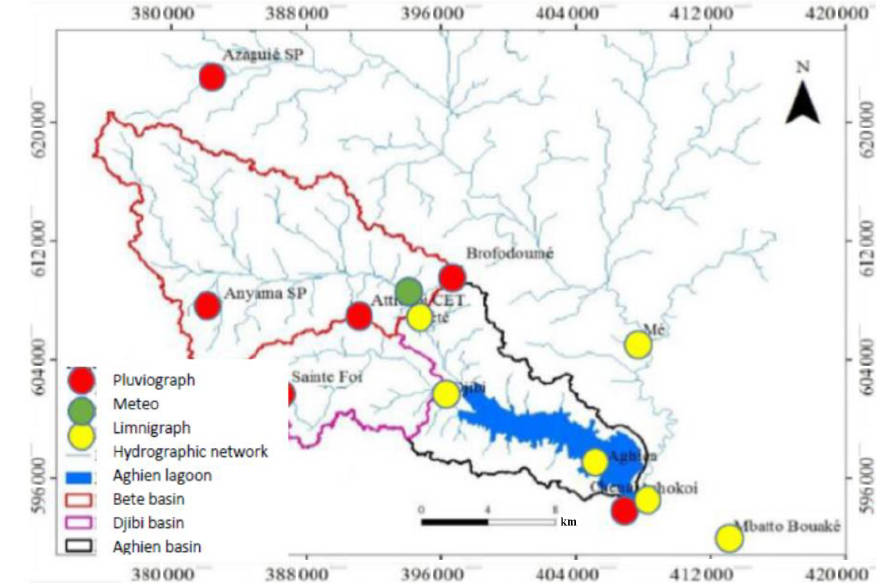
Figure 3. Hydroclimatic measurement network of Aghien lagoon watershed.